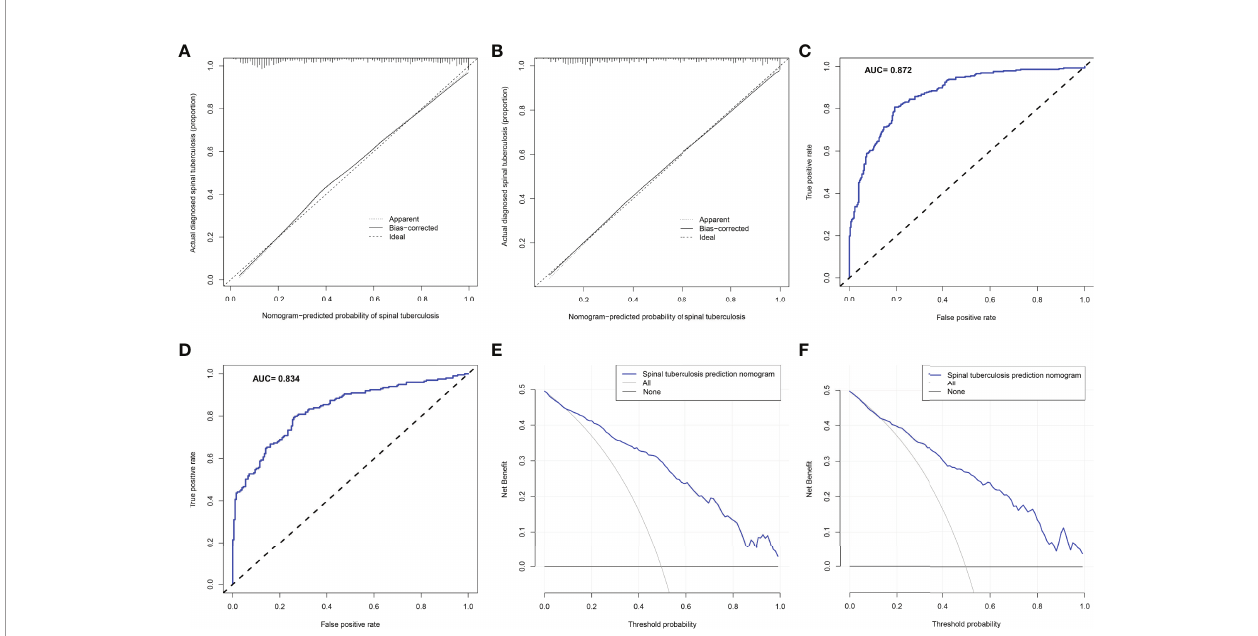
FIGURE 4 | The predictive ability and accuracy of the nomogram model was evaluated. (A) The calibration curve for the training set showed that the nomogram predicted risk of spinal tuberculosis was highly consistent with the actual diagnosis of spinal tuberculosis. (B) The calibration curve for the external validation set showed that the predicted and actual values were also highly consistent. (C) The ROC curve of the training set showed that the AUC of the nomogram model for predicting spinal tuberculosis was 0.862. (D) The ROC curve of the external validation set calculated the AUC to be 0.834. (E) The DCA curve of the training set showed that the net bene fi t of the predictive model ranged from 0.01 to 0.99. (F) , The DCA curve of the external validation set showed that the net bene fi t of the predictive model also ranged from 0.01 to 0.99.